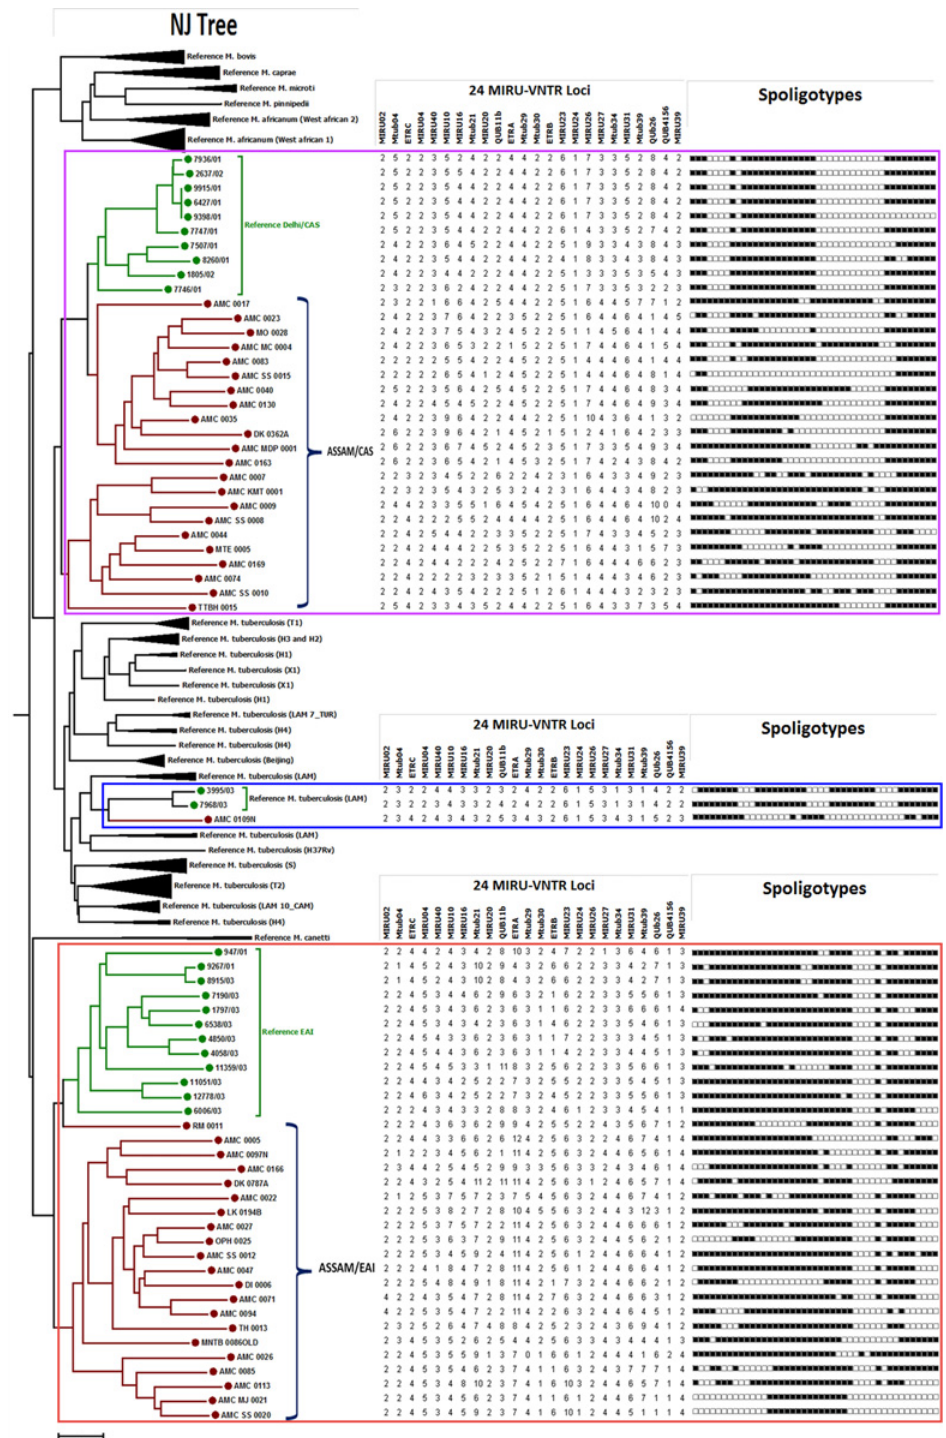
Fig 7. Fig 7 showing phylogenetic relationship of orphan strains of MTBC from Assam with reference MTBC isolates available at the database MIRU-VNTR plus . The NJ tree was constructed using 24-loci MIRU-VNTR data. 24-loci MIRU-VNTR alleles and spoligotypes from 44 isolates are also represented along with MIRU-VNTR NJ tree. This phylogenetic tree clearly shows that the orphan strains of MTBC from Assam represent two new well defined sub-clades namely Assam/EAI and